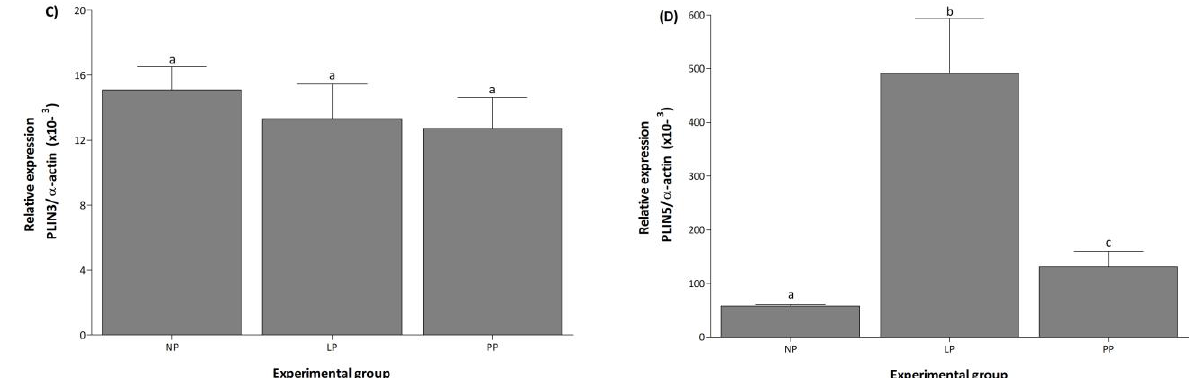
Figure 2. Pregnancy induces the expression of PLIN1, PLIN2, and PLIN5 in the left ventricle. Mean ( ± S.E.M.) mRNA expression levels of PLIN1 ( A ), 2 ( B ), 3 ( C ), and 5 ( D ) in the left ventricle of non-